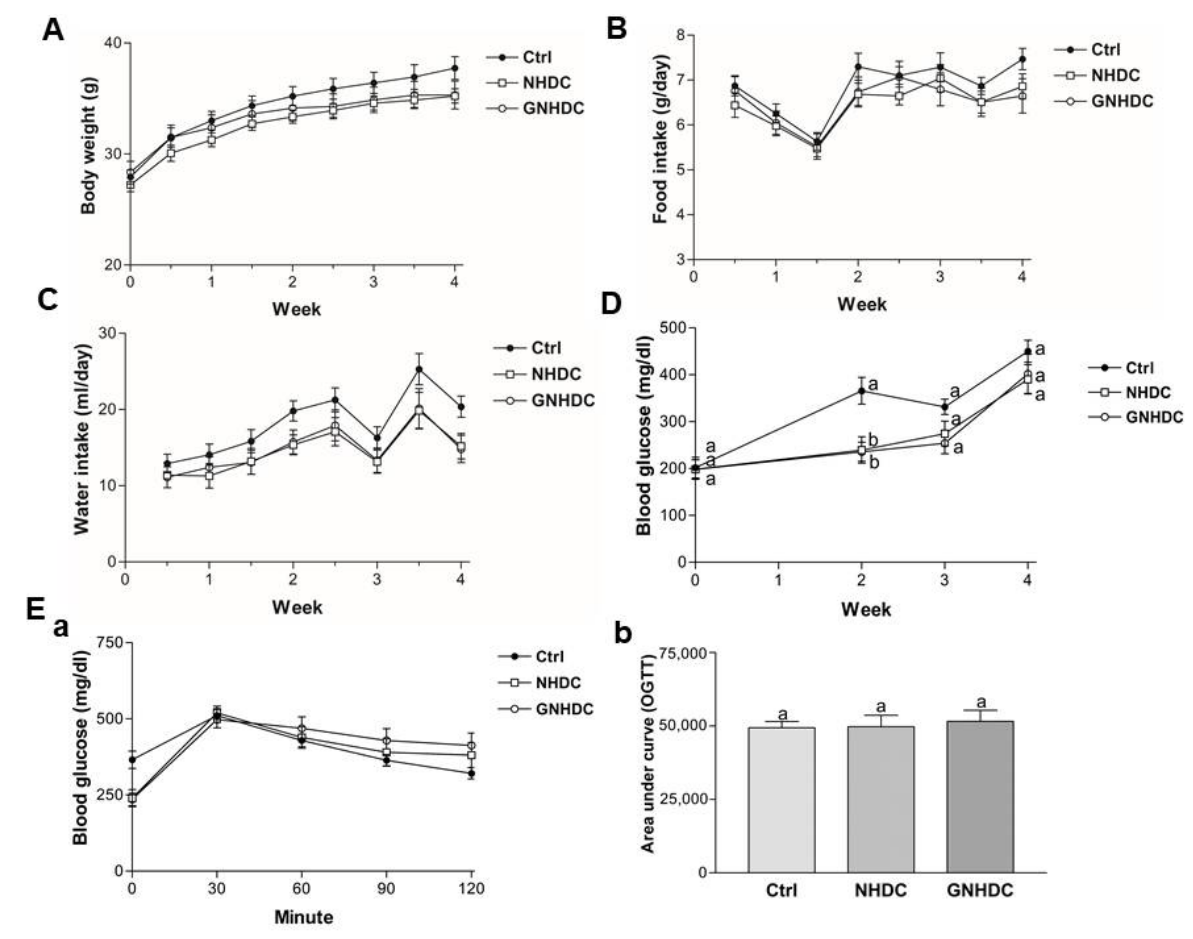
Figure 2. Effects of NHDC and GNHDC on body weight, food intake, water intake, fasting blood glucose levels, and OGTT in db/db mice. Body weight, food intake, water intake, fasting blood glucose levels, and OGTT were analyzed in db/db mice. ( A ) Body weight, ( B ) Food intake, and ( C ) Water intake, and ( D ) changes in fasting blood glucose levels during the experimental period. ( E ) ( a ) OGTT and ( b ) AUC for OGTT are presented. All data are shown as the mean SEM ( n = 9 per group) and were analyzed by one-way ANOVA with a Newman–Keuls post hoc test. OGTT, oral glucose tolerance test; AUC, area under the curve; Ctrl, db/db mice control; NHDC, db/db mice with neohesperidin dihydrochalcone supplement; GNHDC, db/db mice with NHDC-O-glycoside sup- plement. The same letter indicates no significant differences ( p > 0.05) and different letters indicate significant differences ( p < 0.05, ANOVA).